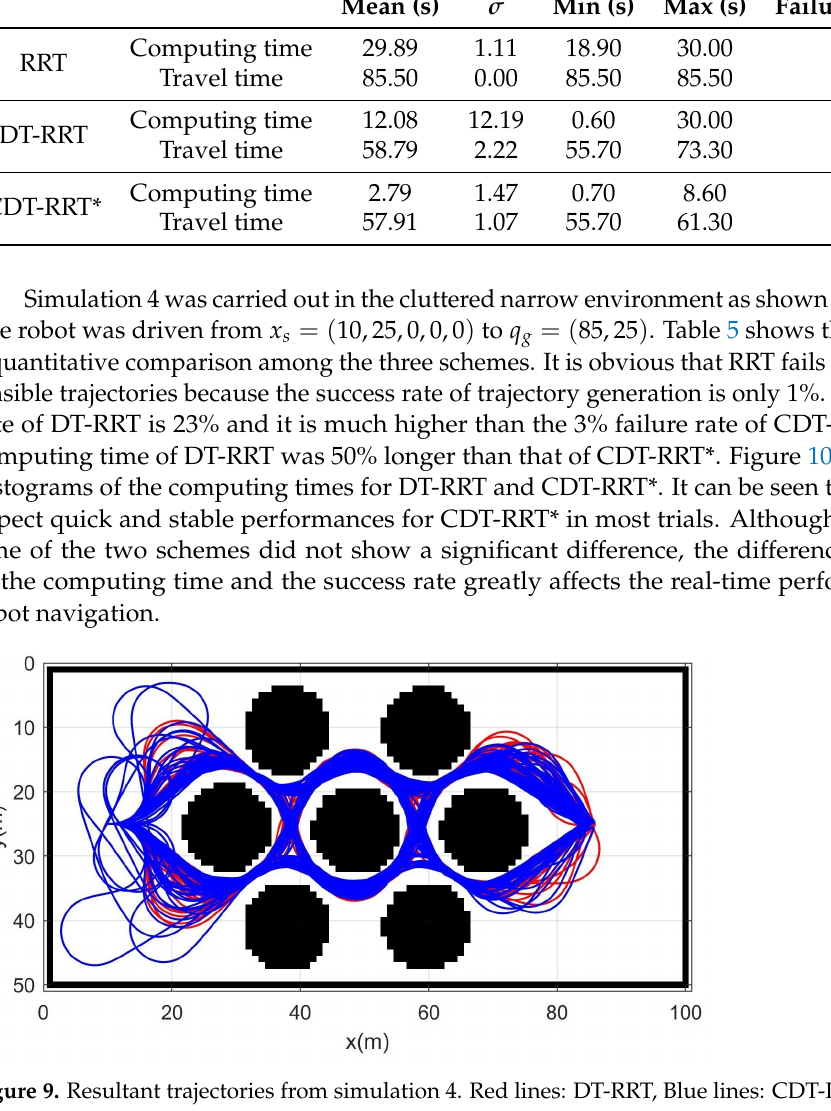
Figure 9. Resultant trajectories from simulation 4. Red lines: DT-RRT, Blue lines: